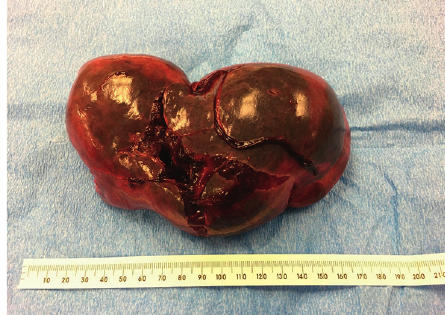
Figure 3: Appearance of the spleen after splenectomy. The capsular surface was hemorrhagic with an irregular 10cm laceration in the mid portion nearly bisecting the spleen with an intact